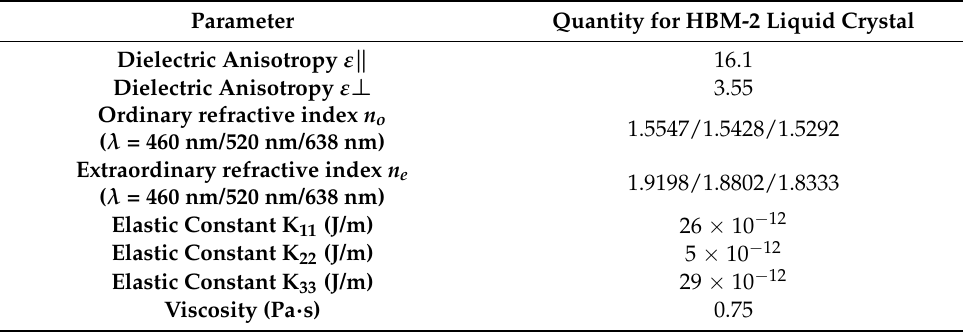
Table 1. Material parameters of HBM-2 nematic liquid crystal mixture, at room